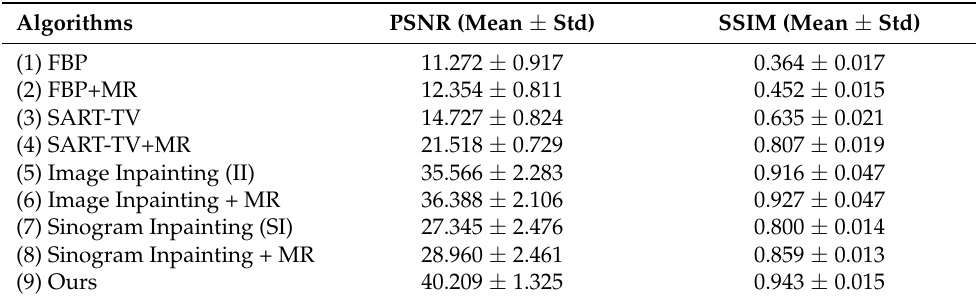
Figure 11. Visualized restoration results of various methods. Table 7. Methods Comparison.